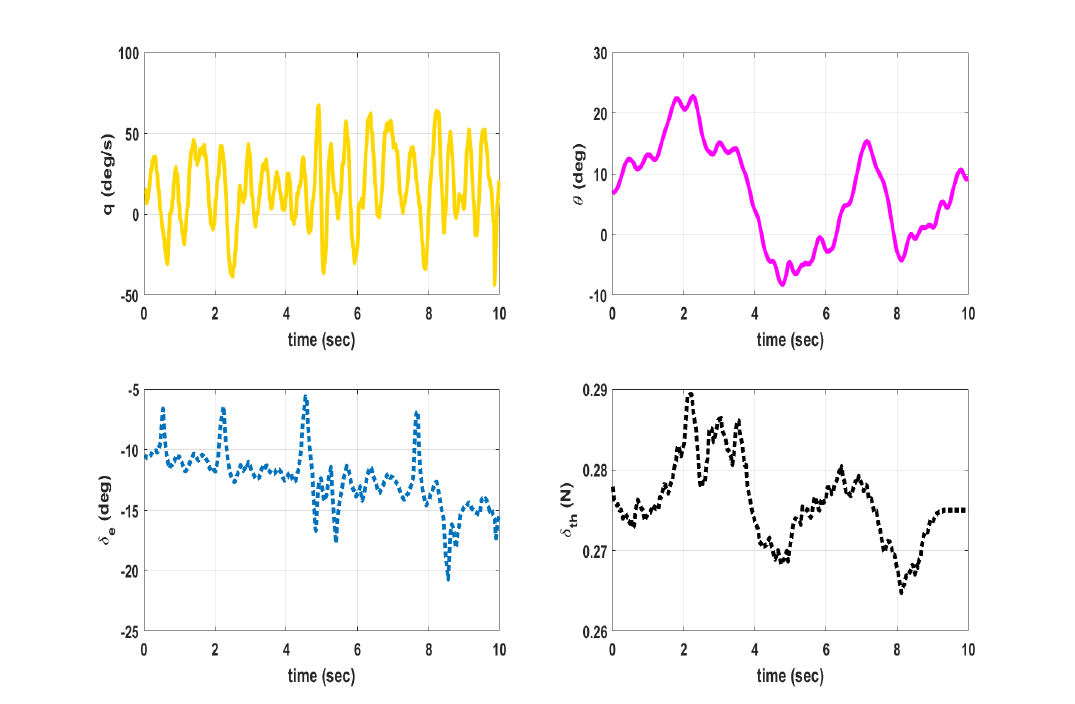
Figure 13. Outputs ( q , θ ) and inputs ( δ e , δ th ) for longitudinal